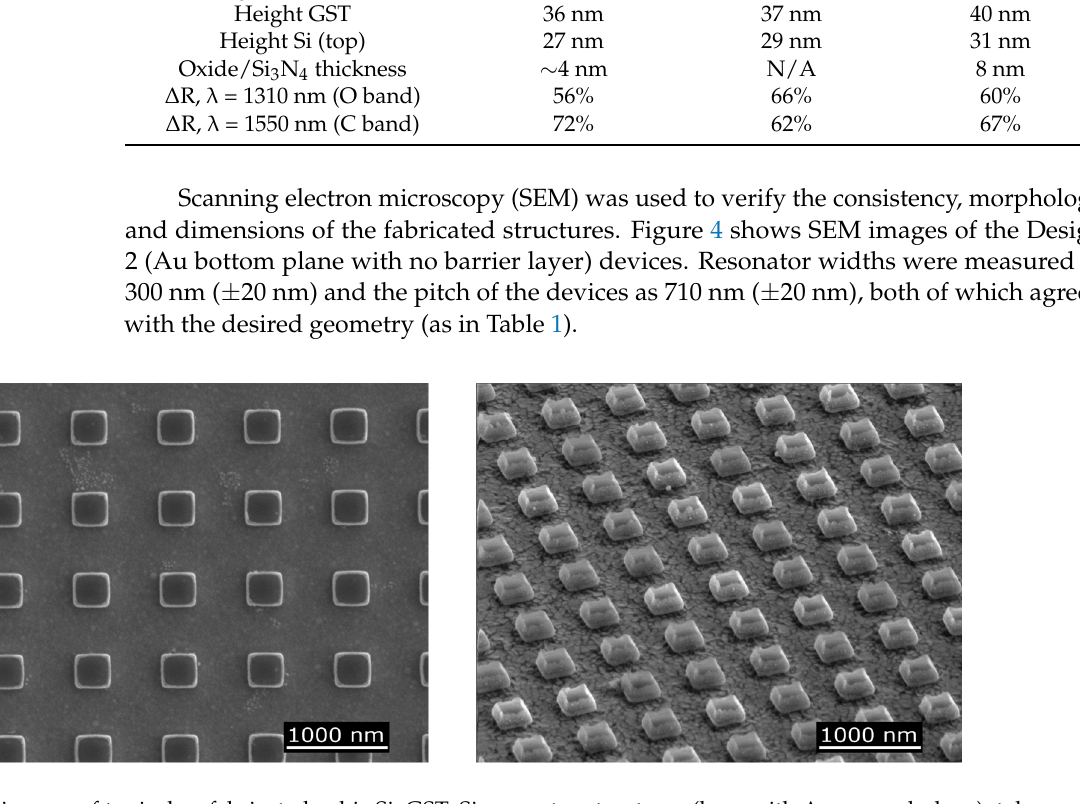
Figure 4. SEM images of typical as-fabricated cubic Si–GST–Si resonator structures (here with Au ground plane), taken ( left ) at normal incidence and ( right ) tilted at a 52 ° angle.